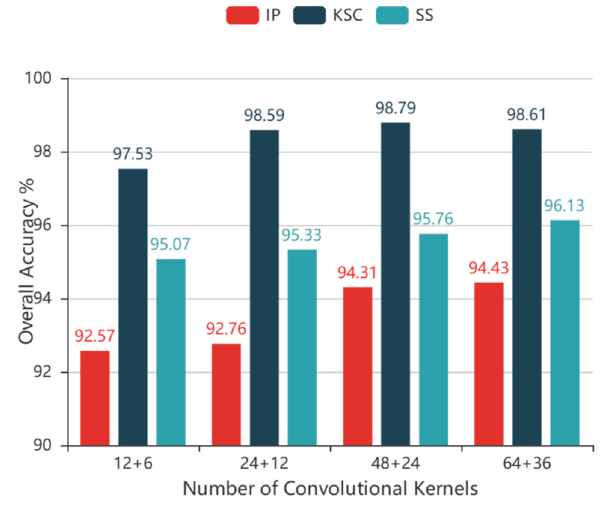
Figure 7. The overall accuracy of the AUSSC with different numbers of convolutional kernels in the first layer using two blocks. The 𝑎 + 𝑏 notation on the x -axis denotes an AUCN with 𝑎 kernels in the first convolutional layer and 𝑏 kernels in the two blocks.